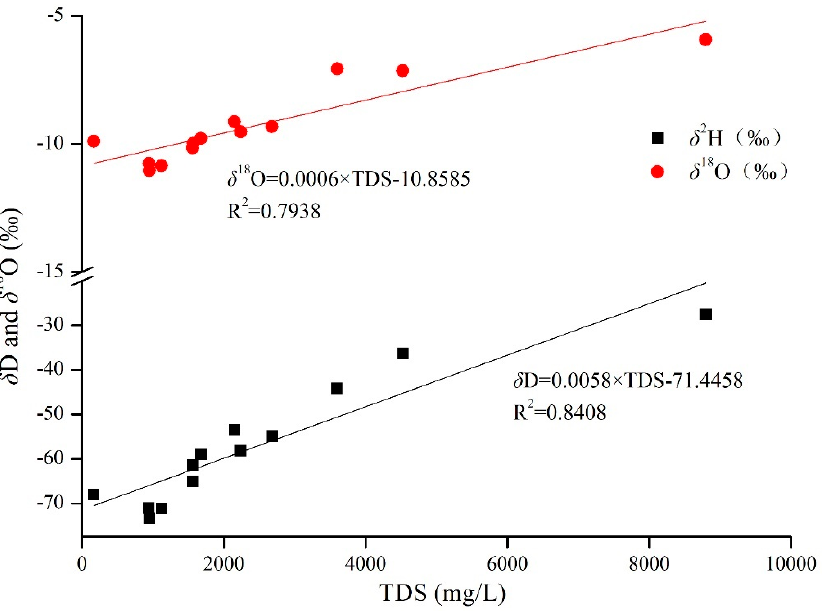
Figure 4. Relationship between the isotopic compositions and the TDSs of water samples.